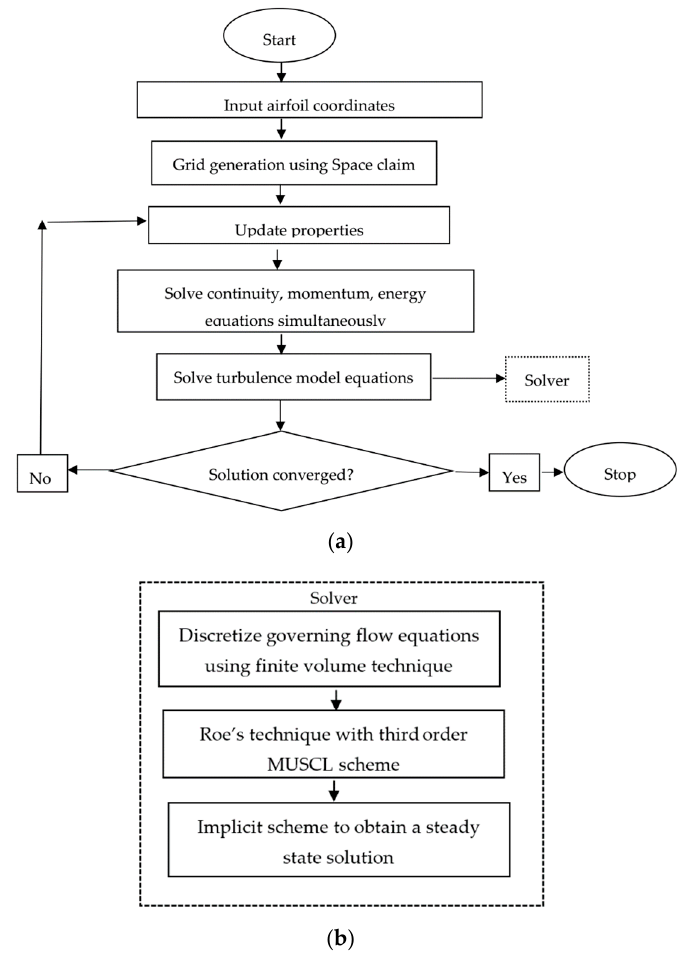
Figure 7. ( a ) Algorithm flow chart used in the current numerical simulations. ( b ) Solver flow chart.